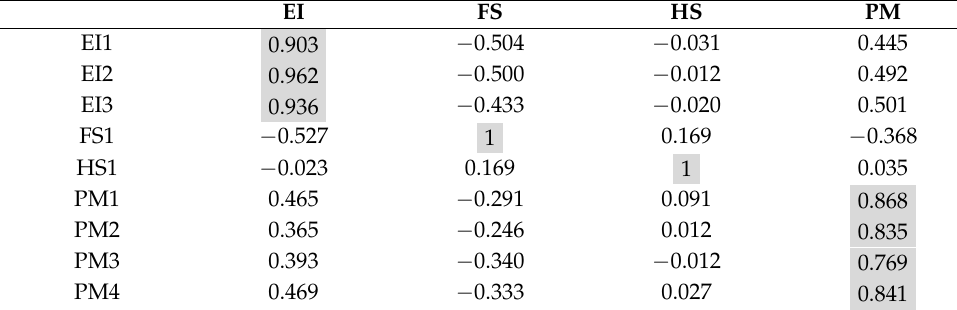
Table 4. Discriminant validity—factor loadings and cross-loadings.